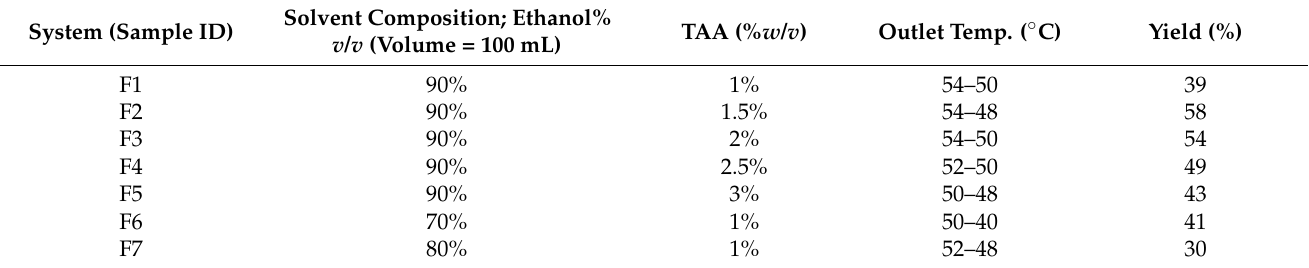
Table 1. Spray-drying parameters and input parameters for TAA spray-dried products without blowing agent